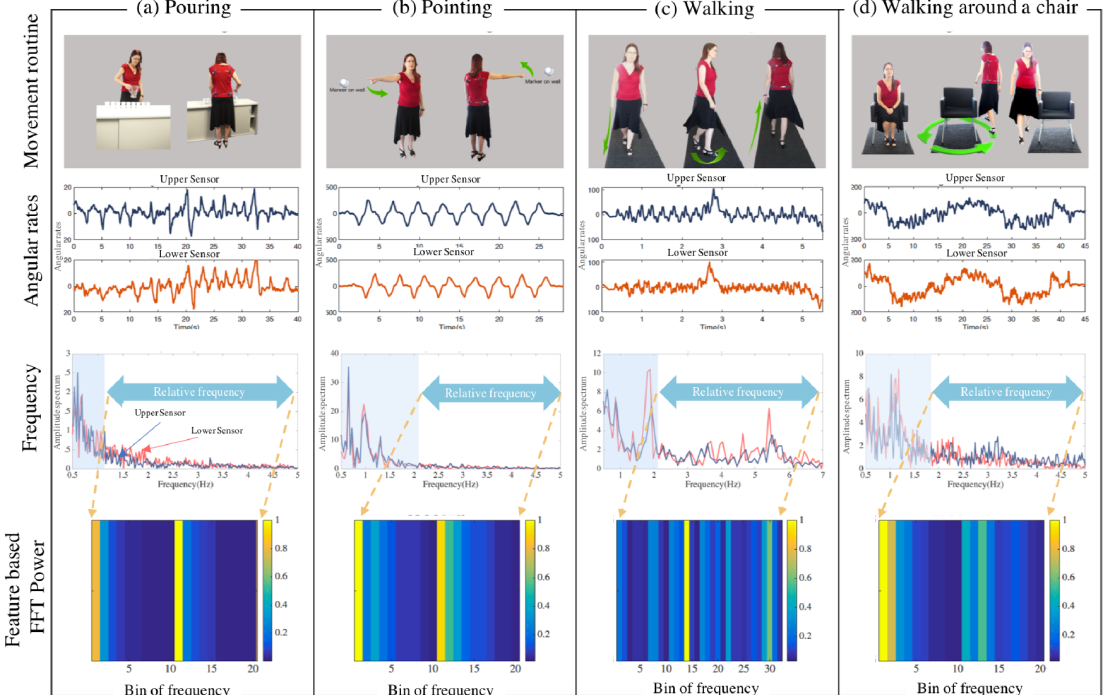
Figure 2. Experimental setup and analysis. Figure ( a – d ) demonstrates movement routine for pouring, pointing, walking and walking around a chair; the second row depicts angular rates in time domain from sensors at the upper and lower; the third row indicates frequency domain (FFT) representation for each of the movement routine. Here, upper sensor (red) and lower sensor (blue), and the dominant frequency band is indicated in a shaded area; the fourth row shows examples of power spectral density of the relevant band forming the feature